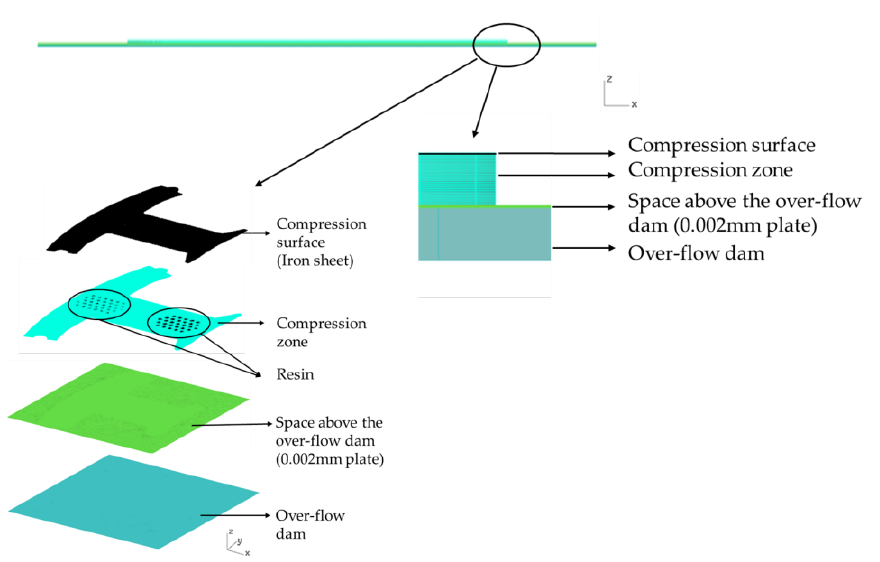
Figure 8. Mesh model used in the dipping process.